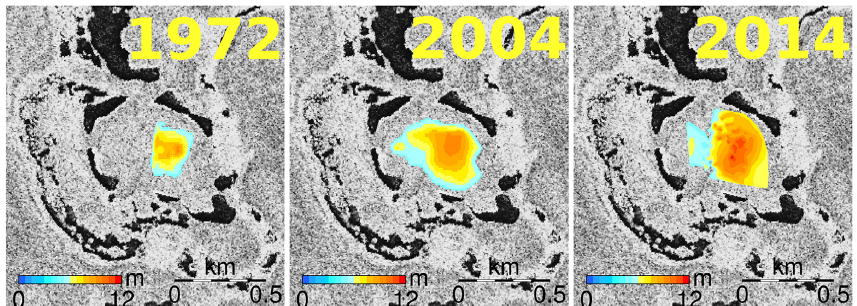
Figure 5. Elevation ( > 5m) in 1972 and 2004 from stereo-photo analysis and in 2014 from Total Station surveys. Background is 14 August 2014 radar backscatter